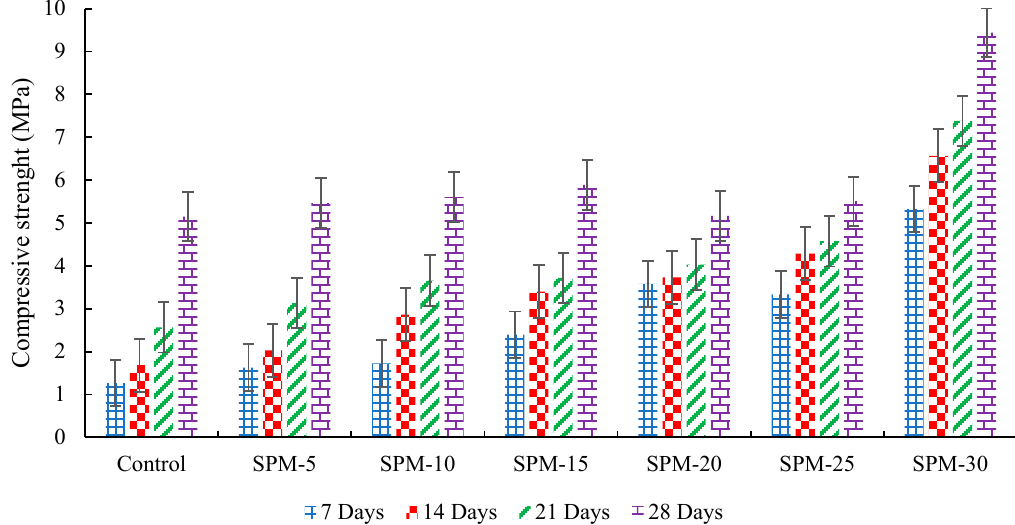
Figure 4. Compressive strength development of SPs-based mortars.